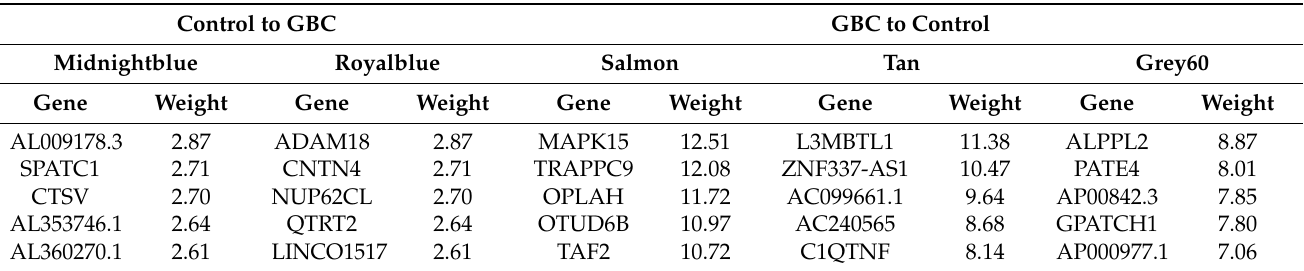
Table 1. Identification of hub genes from non-preserved modules in GBC and control condition through Intramodular connectivity approach. Control to GBC GBC to Control